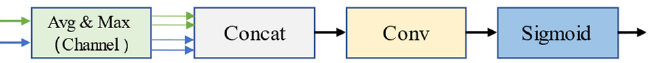
Figure 8. Spatial Attention Module.